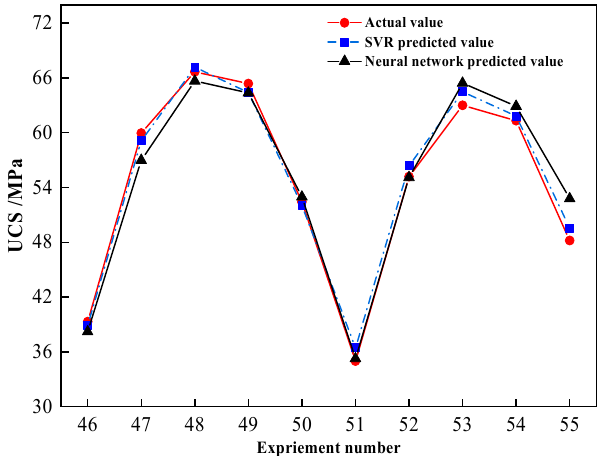
Figure 10. Comparison of predicted results of seawater immersion of sample A for 300 days.